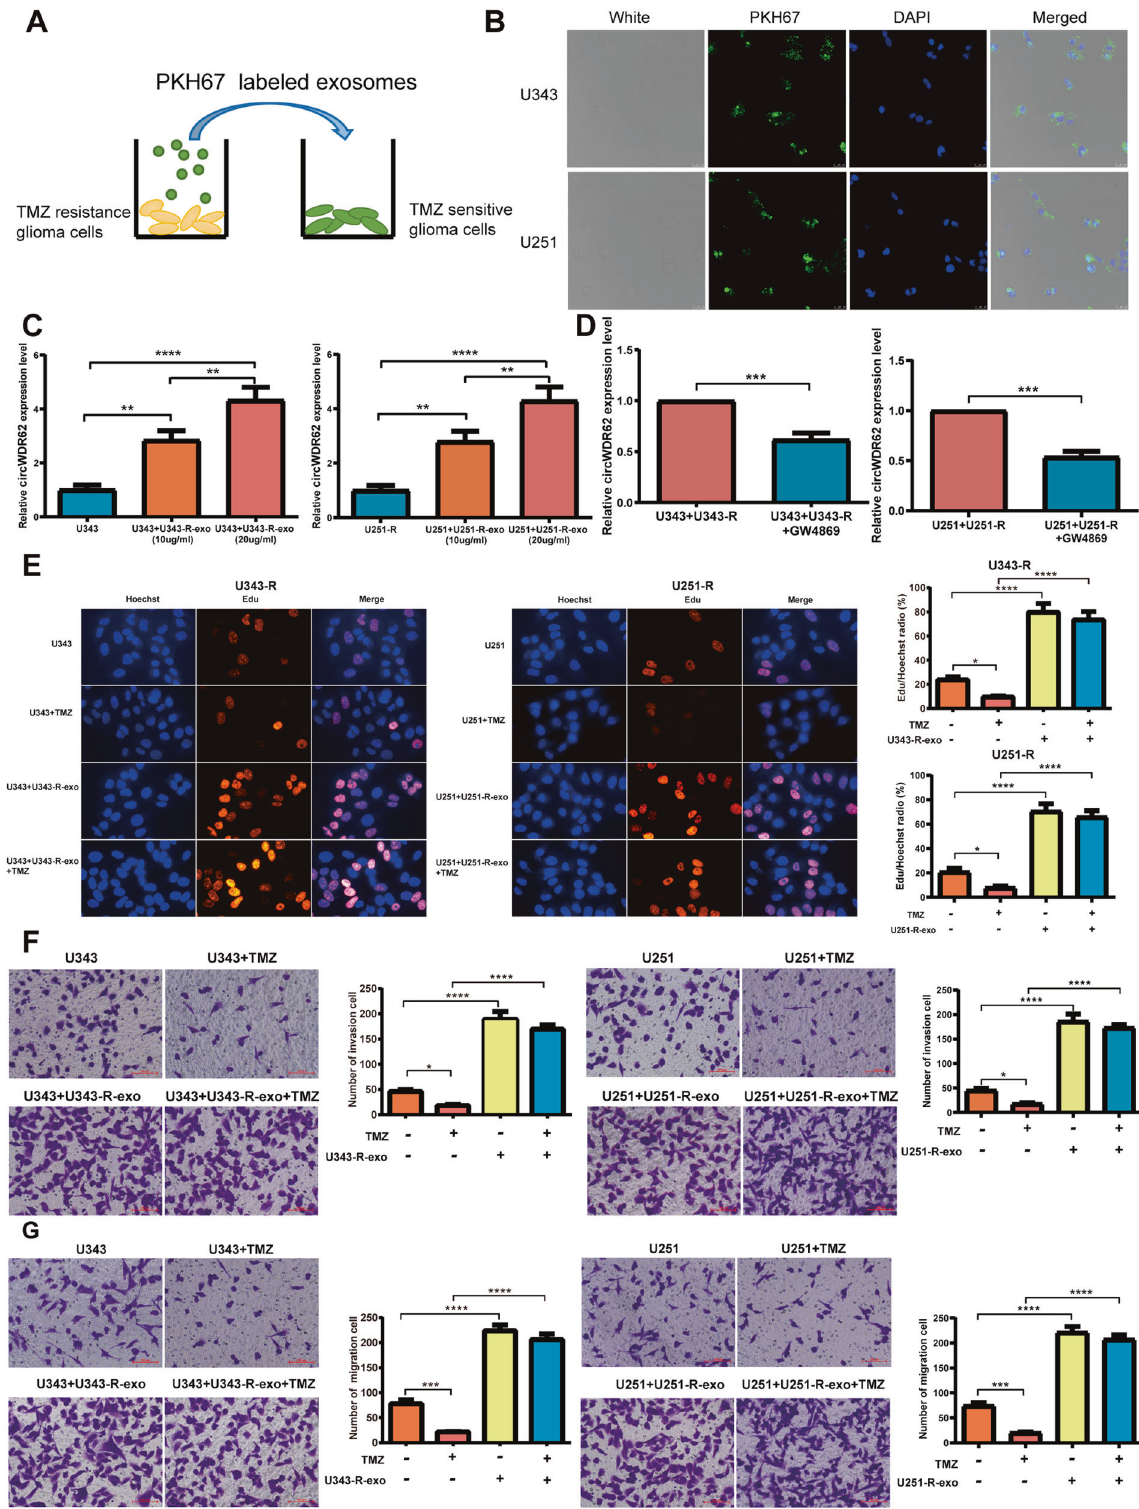
Fig. 7 Exosome-mediated delivery of circWDR62 induces TMZ resistance and malignant progression of glioma cells in vitro. A Exosomes from TMZ-resistant glioma cells were labelled with PKH67 and then cocultured with TMZ-sensitive glioma cells. B PKH67-labelled TMZ-resistant glioma cell-derived exosomes were endocytosed by TMZ-sensitive glioma cells. C The expression levels of circWDR62 in TMZ-sensitive glioma cells were measured by qRT – PCR after treatment with TMZ-resistant glioma cell-derived exosomes. D The effects of the EV secretion inhibitor GW4689 on circWDR62 transport from U343-R and U251-R cells to U343 and U251 recipient cells. E The EdU assay was performed to assess the proliferation ability of TMZ-sensitive glioma cells after treatment with TMZ-resistant glioma cell-derived exosomes. F , G Transwell assays were performed to assess the cell invasion ( F ) and migration ( G ) of TMZ-sensitive glioma cells after treatment with TMZ-resistant glioma cell-derived exosomes.